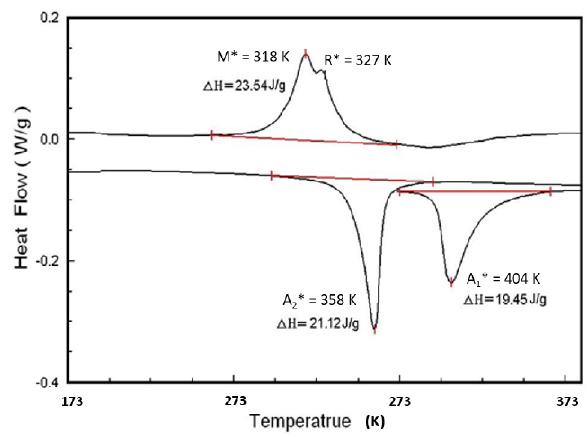
Figure 7. DSC curve of the Ti 50 Ni 49 W 1 alloy after 5% cold rolling.